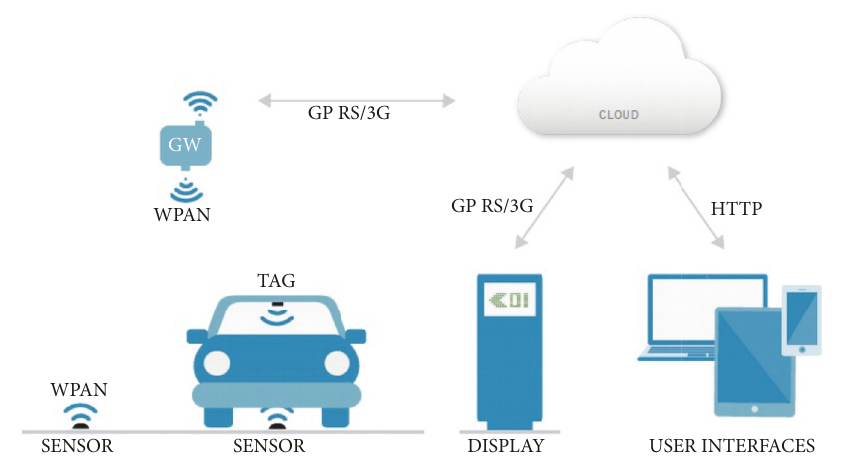
Figure 4: Sensor based smart parking overview.